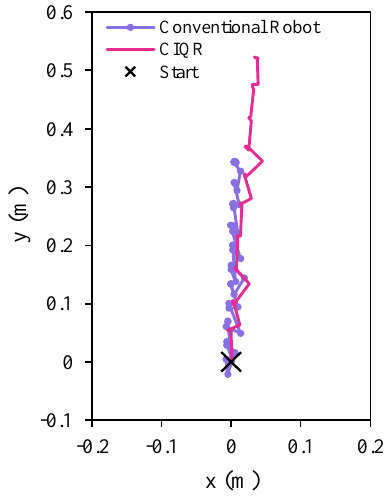
Figure 18. Comparison of trajectories traveled by a conventional robot and CIQR-based robots with three legs